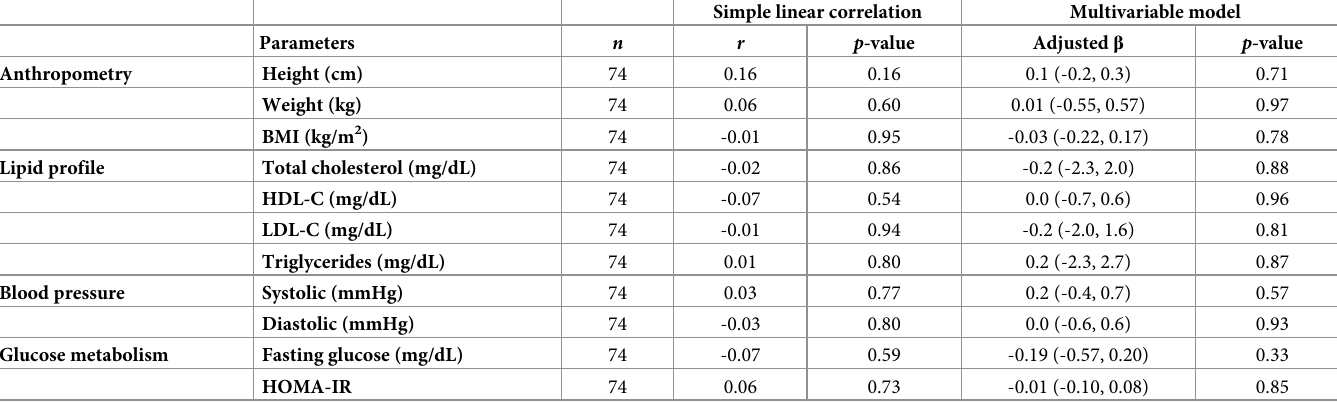
Table 5. Associations between maternal plasma zinc concentrations in late pregnancy and anthropometric and cardiometabolic outcomes in the young adult